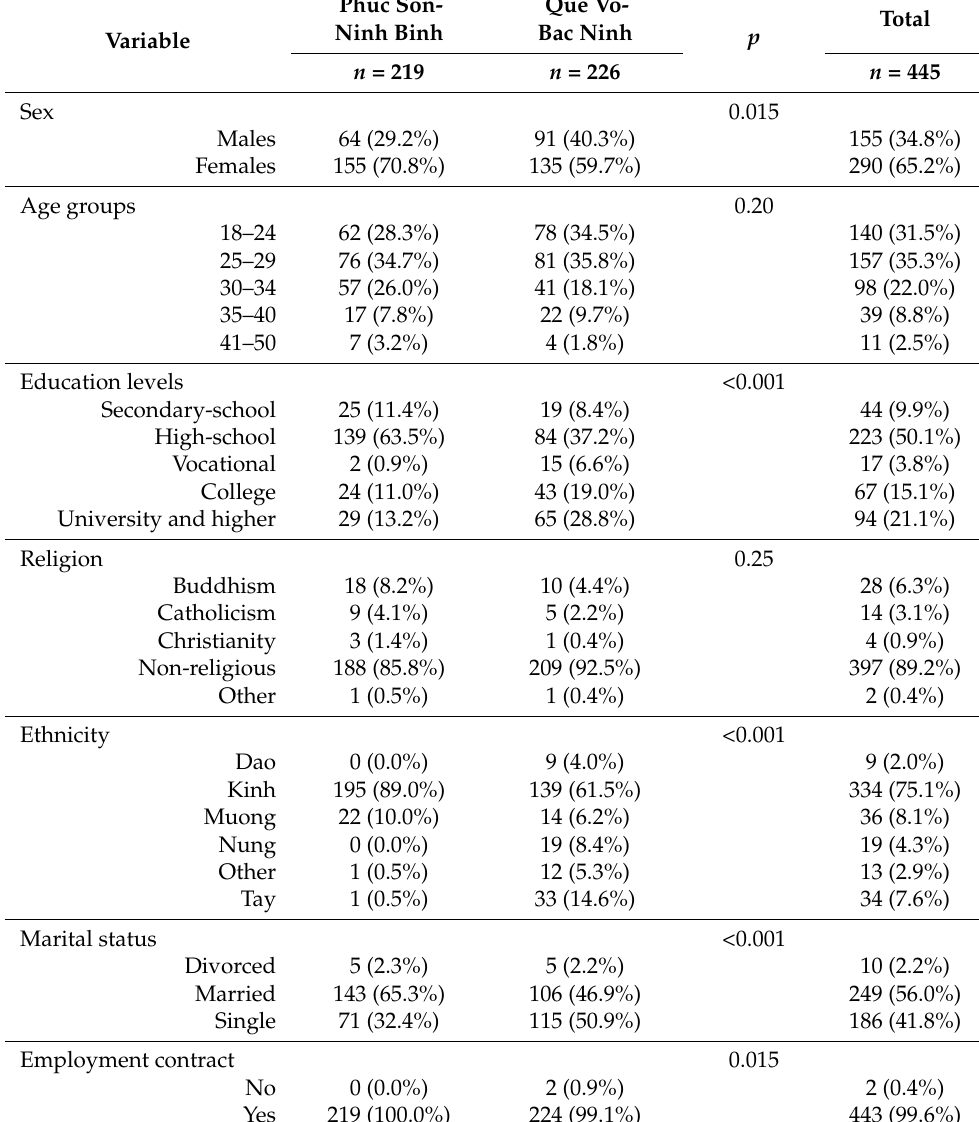
Table 1. Demographic information of migrant